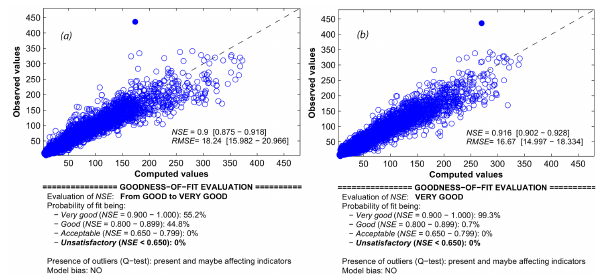
Figure 7. Goodness-of-fit evaluation for validation period (1989– 1997) at the Astor watershed: (a) UBCANN method and (b) UBC- CLA method.